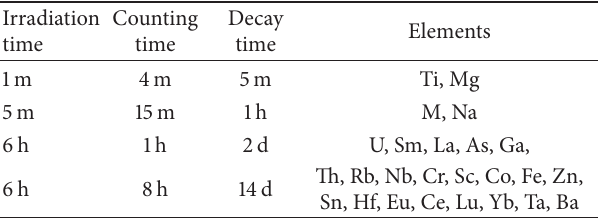
Table 1: Irradiation conditions for the elements determined.